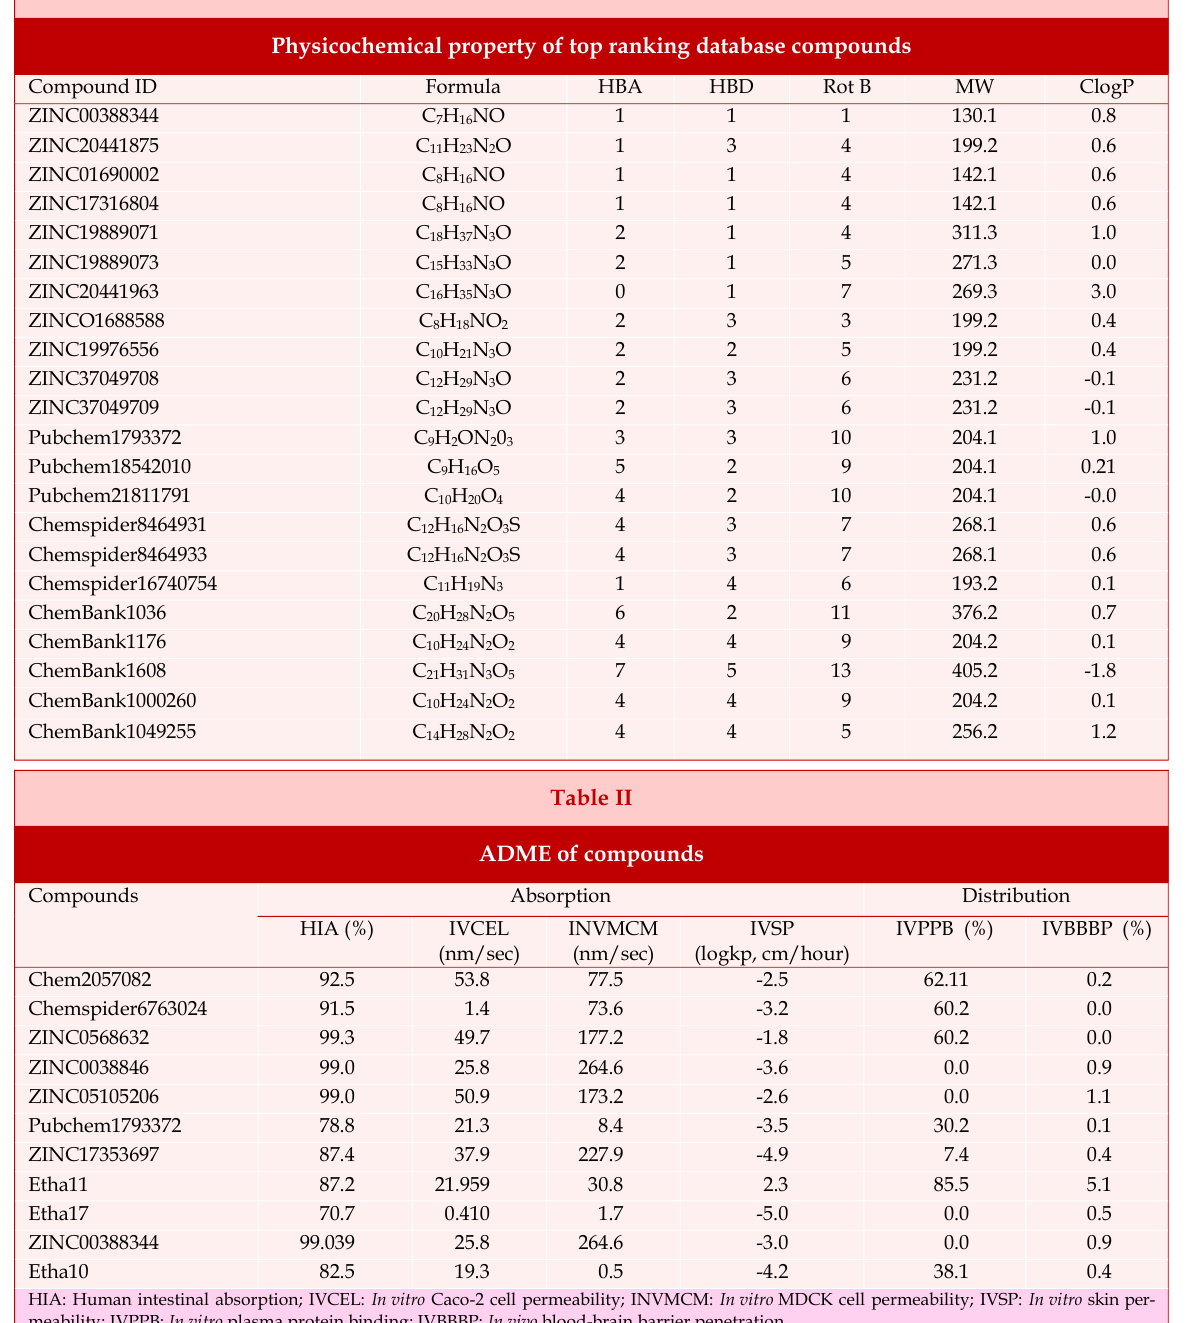
ADME of compounds